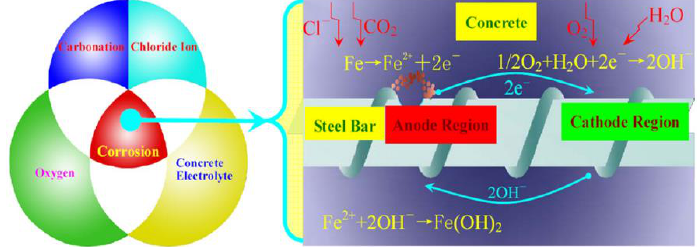
Figure 6. Schematic representation of the reinforcing steel’s corrosion process in concrete. Reproduced with permission from ref. [99]. Copyright 2011 Elsevier.